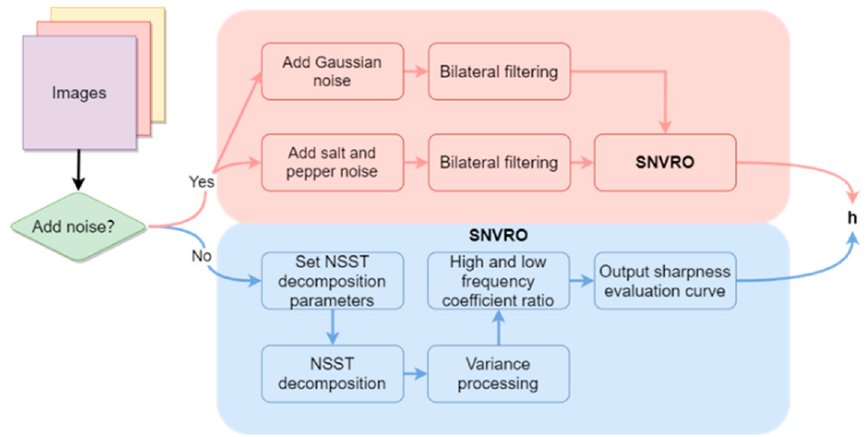
Figure 2. Flow chart of sharpness evaluation curve.